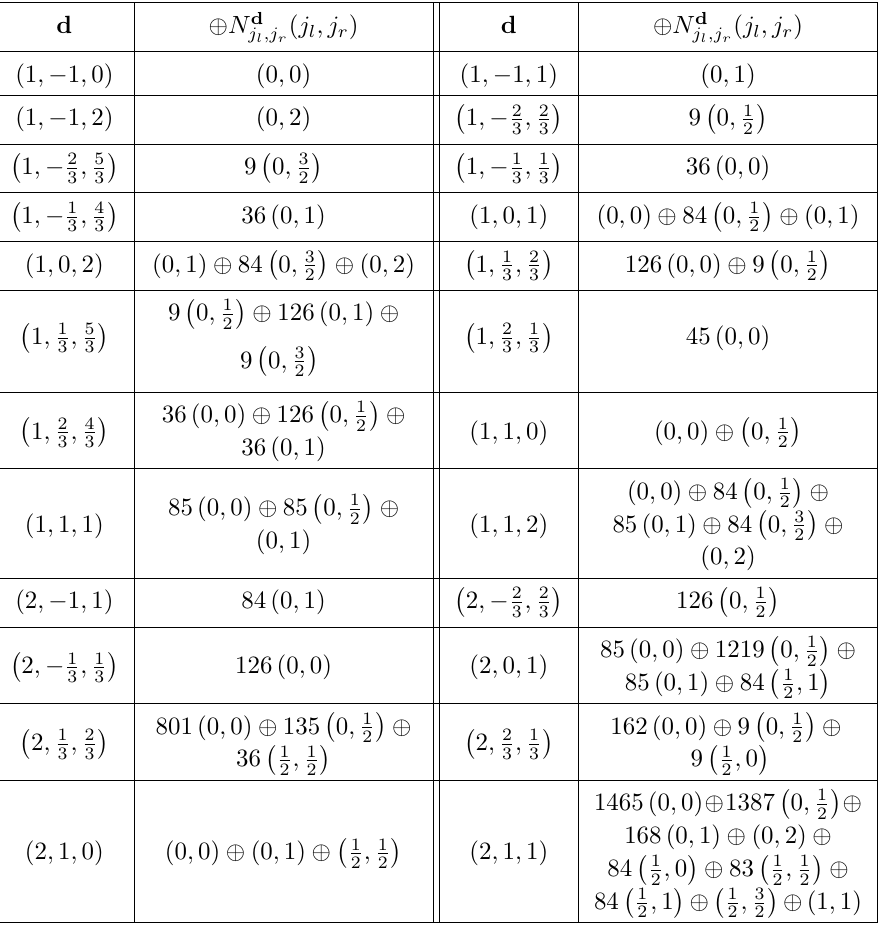
Table 17. BPS spectrum of the SU(3) + 9 F theory for d 1 = 1 , d 2 ≤ 1 , d 3 ≤ 2 and d 1 = 2 , 3 / 2 d 2 , d 3 ≤ 1 . All flavor mass parameters m i =1 , ··· , 9 are turned off and d = ( d 1 , d 2 , d 3 ) labels the BPS states with charge d 1 m 0 + d 2 α 1 + d 3 α 2 for the simple roots α 1 and α 2 of su (3)